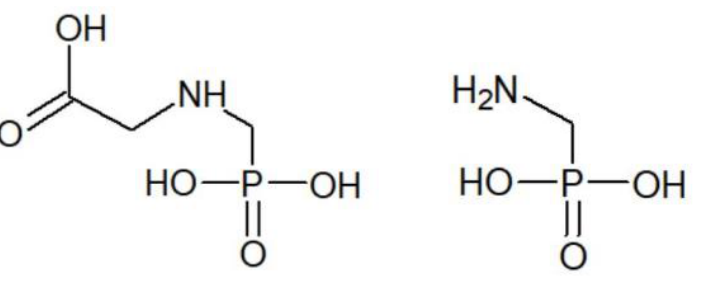
Figure 1. Chemical structure of glyphosate ( left ) and aminomethylphosphonic acid ( right